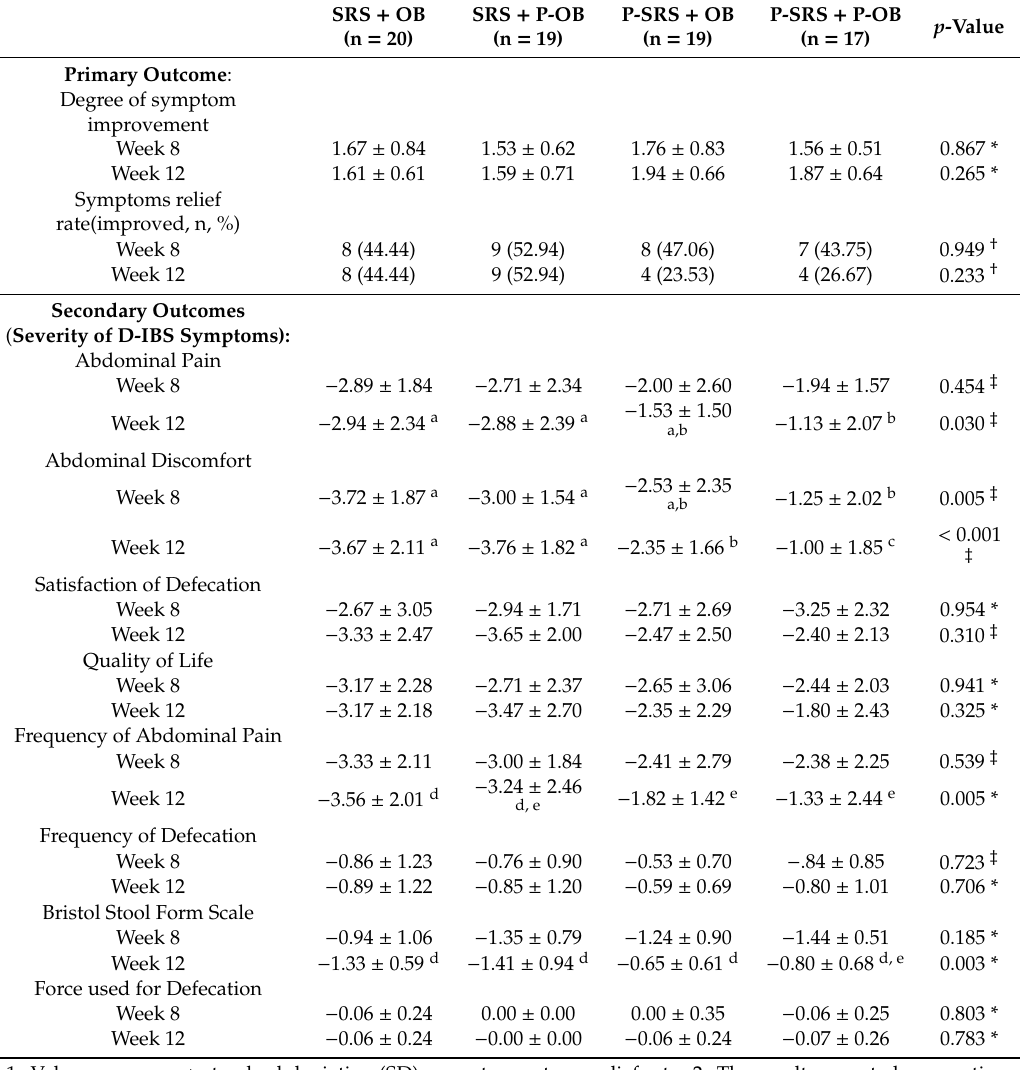
Table 4. Outcome results (ITT